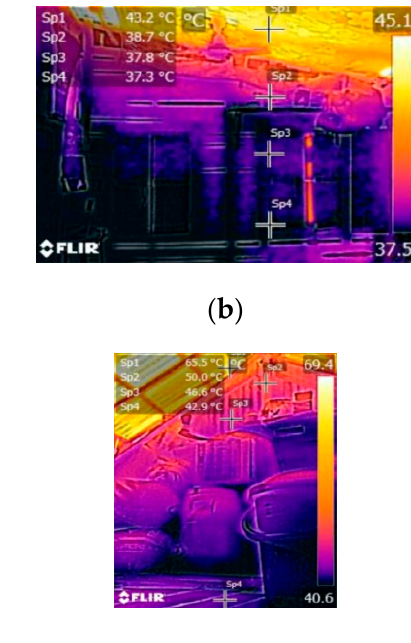
( d ) Figure 7. Surface temperature of H-3: ( a ) outdoor, ( b ) under elevated platform, ( c ) roof and ( d ) room interior. In terms of roof, in H-1, a non-insulated CI sheet had internal surface temperature of 47.8 °C. But in H-2 and H-3, with a 12–18 mm thick wooden insulation, inner surface temperature decreased by 12.7 °C and 16.5 °C (Figures 6 and 7) respectively. The first floor’s roofs of H-1 and H-2 are provided with an attic and wooden false-ceiling (Figure 3). This resulted in surface temperature differences of 16.1 °C and 4.5 °C between external and internal ceiling surfaces of H-1 and H-2, respectively. Table 6 shows temperatures of interior and exterior surfaces between 12:00 pm–4:00 pm. Table 6. Surface temperature (mid-day:12:00 pm–4:00 pm) differences of timber house envelope. House/Level Floor (°C) (avg.) Wall (°C) (avg.) Roof/Ceiling (°C) (avg.)